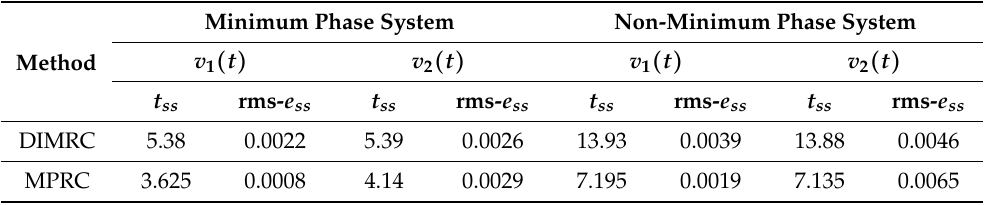
Table 1. Steady-state performance of the DIMRC and